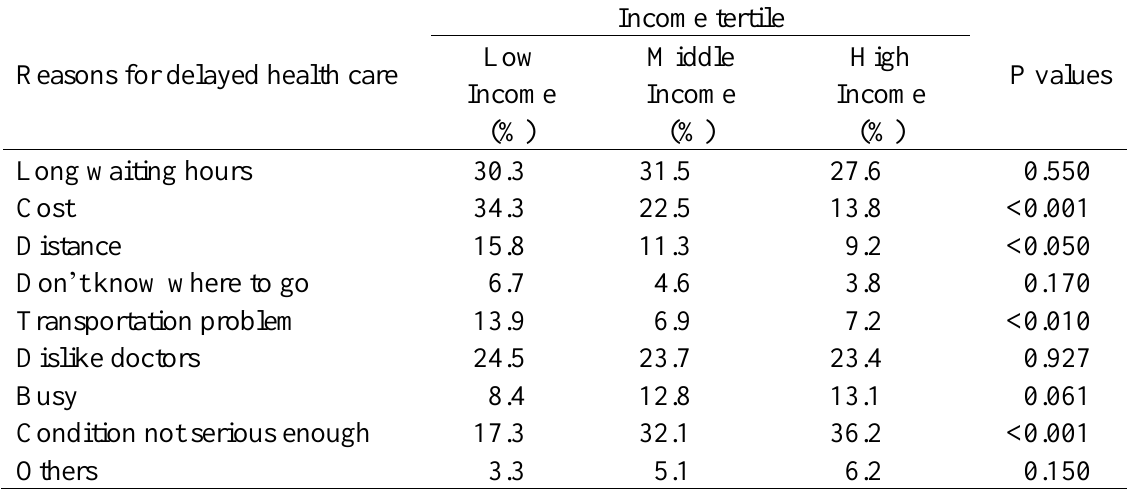
Table 3. Association between reasons for delayed health care and income (N =